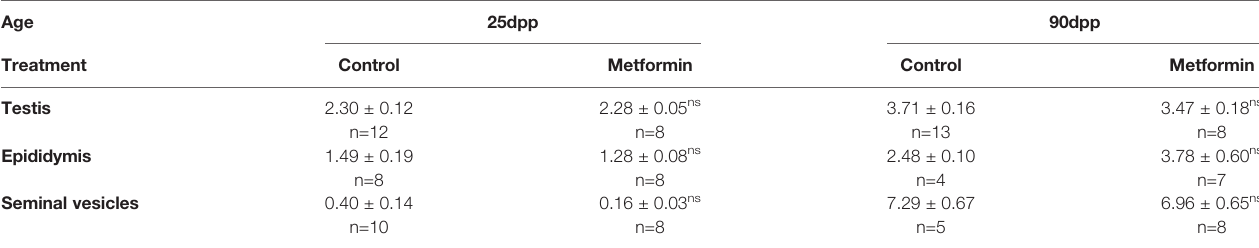
TABLE 1 | Weight of reproductive organs in adult males (90dpp) exposed in utero (mg of tissue)/body weight (g).